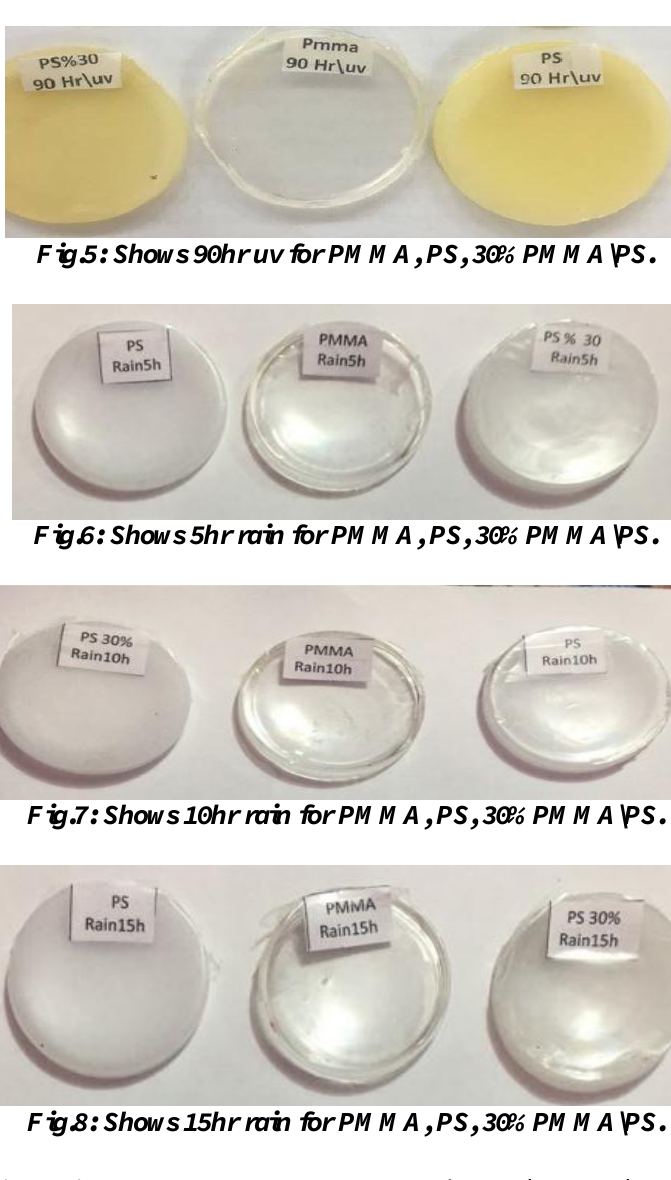
miscibility of the blend